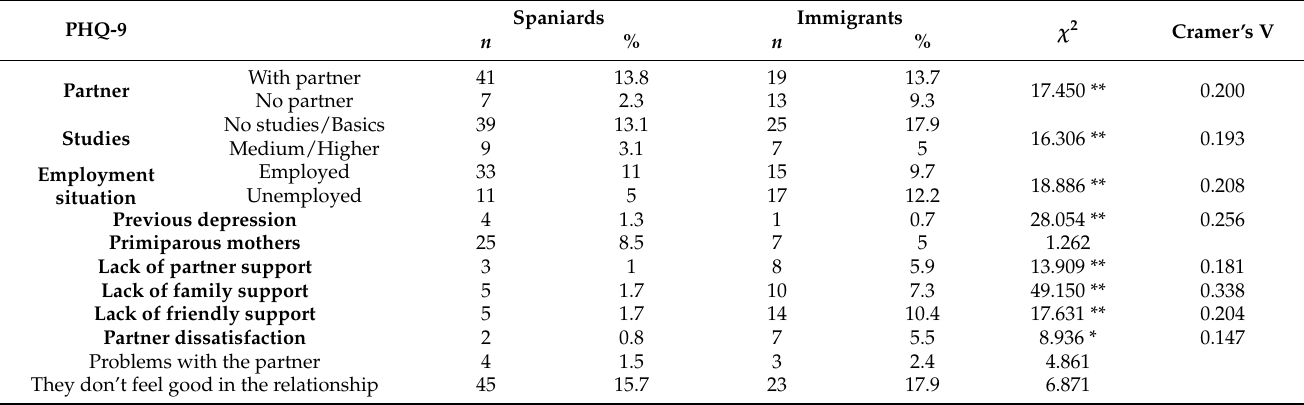
Table 3. Prevalence of sociodemographic factors and symptoms of depression by origin.